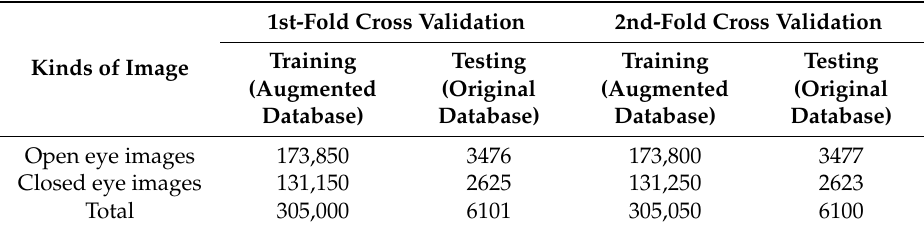
Table 4. Descriptions of training and testing databases in two-fold cross validation.